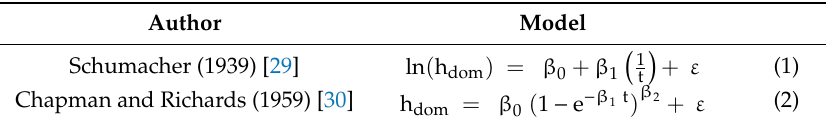
Table 3. Statistical models used to predict dominant